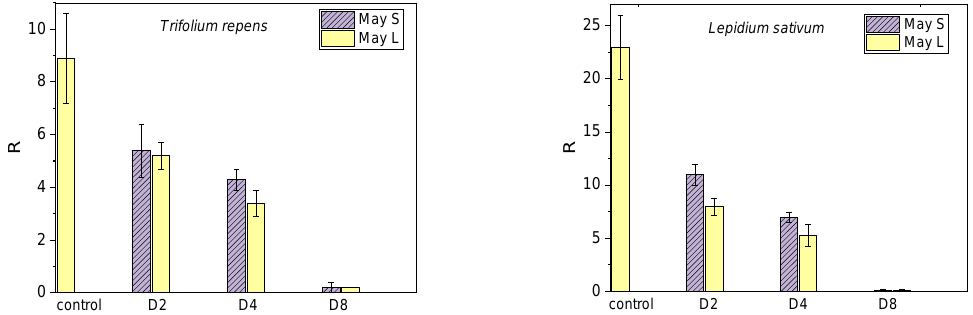
Figure 2. Rates of Trifolium repens ( left ) and Lepidium sativum ( right ) seed germination (R) measured at 7 and 5 dpi, respectively, in the presence of macerates prepared with leaves collected in May from trees facing north (S) or exposed to solar light (L). Mean values of four replicates (± standard error). The pH of macerates decreased during maceration from 5.9 at time 0 to 5.1 at D4 for macerate S and from 5.9 to 4.9 for macerate L. To investigate the pH effect on seed germination, we compared the effect of macerates S-D8 and L-D8 of May with and without neutralization using sodium